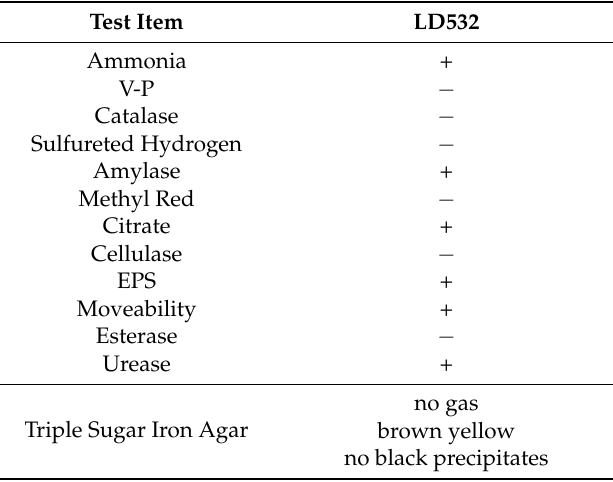
Table 1. The physiological and biochemical identification of C. israelensis .